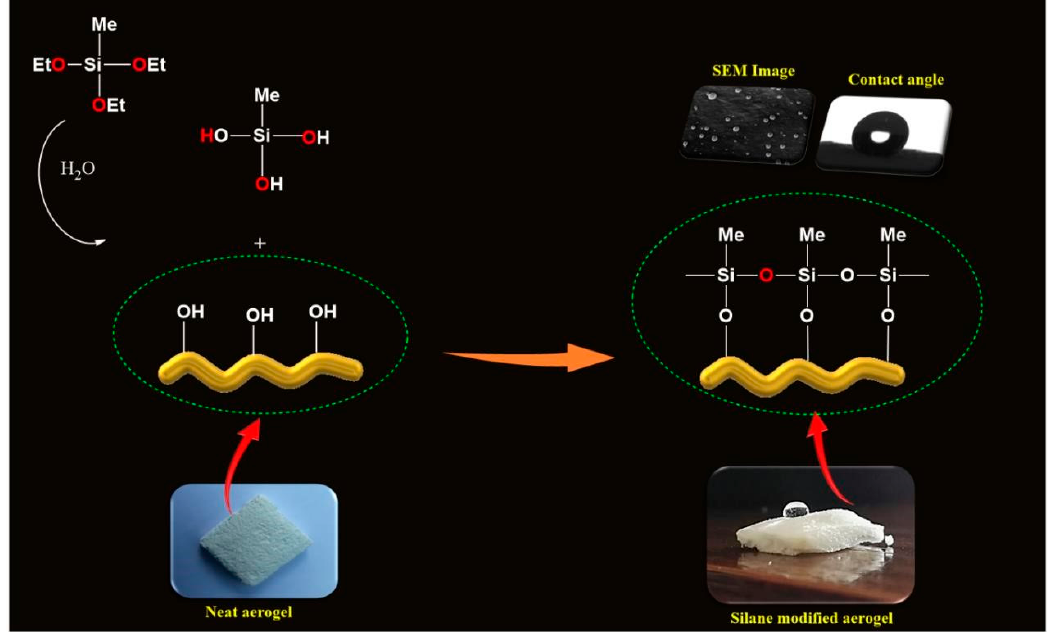
Figure 3. The strategy for the formation of polysiloxane particles during the silane modification of CNF aerogels.